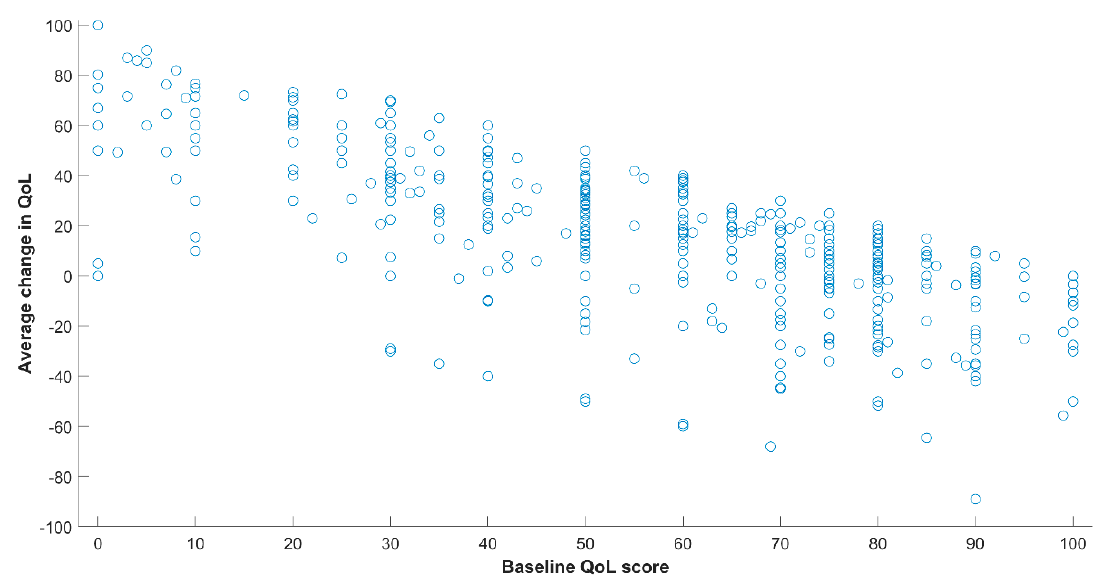
Figure 5. Scatter plot of the change in QoL scores relative to baseline scores.